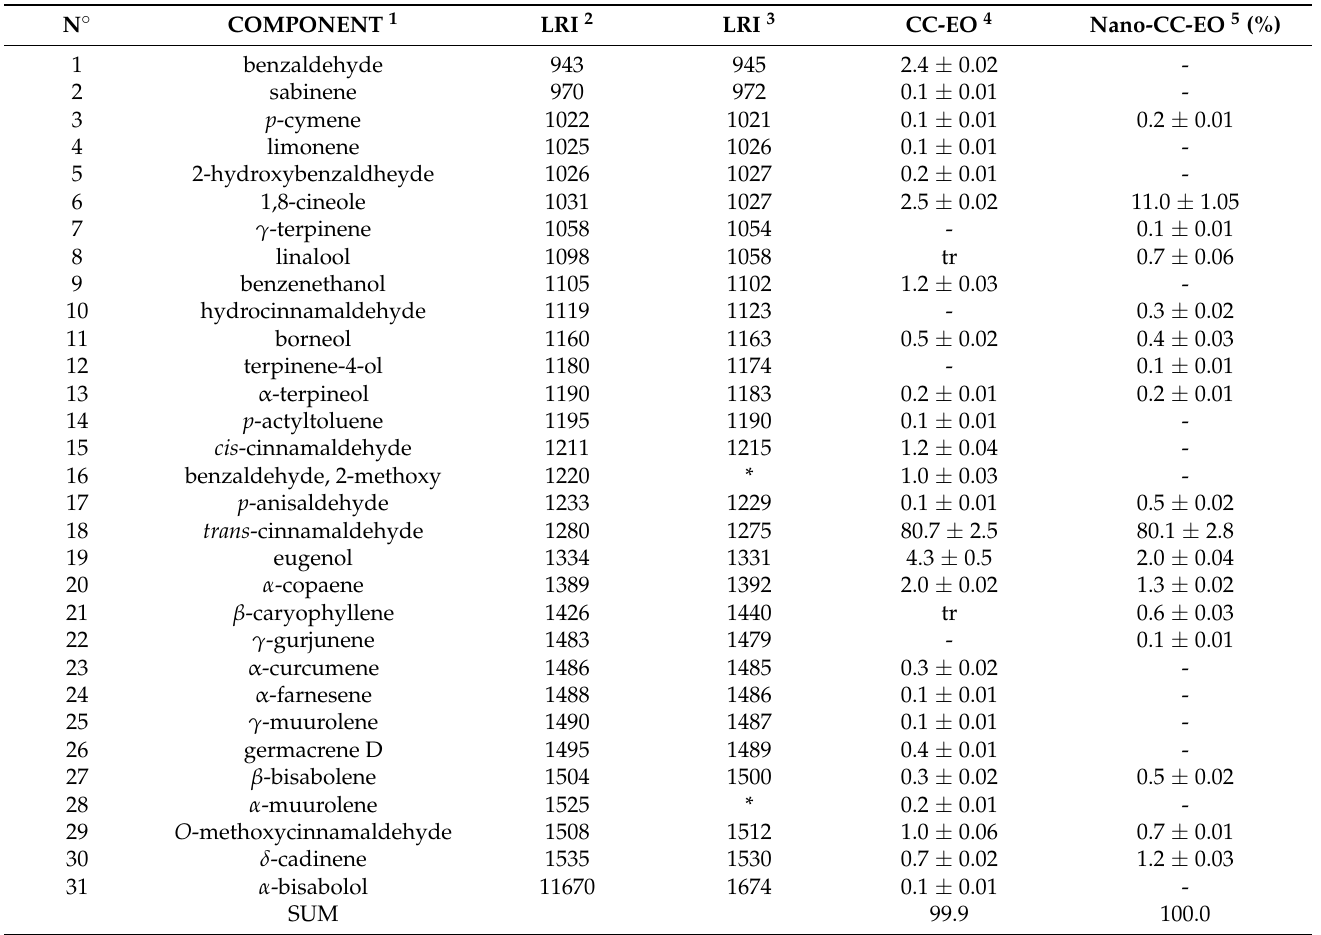
Table 3. Chemical volatile composition (relative percentage mean values ± standard deviation) of pure and nano-encapsulated C. cassia EO.